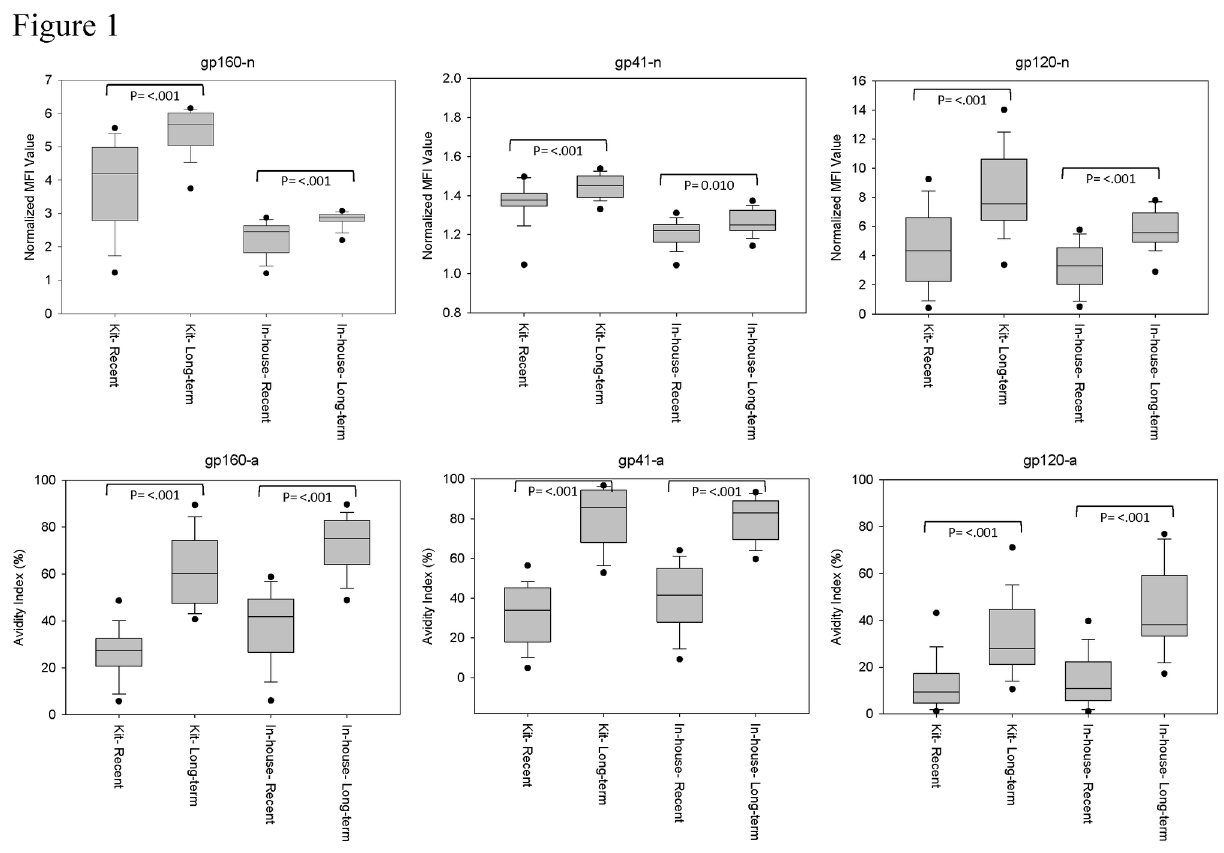
Figure 1. Performance of in-house assay versus prototype kit. The normalized MFI values (n) and avidity index (a) for the in- house assay and kit were compared for drug naïve, known recent (infected <6 months) and long-term (infected >1 year) specimens. The boxes represent the 25 th to 75 th percentile of reactivity, while the middle lines represent the median values. Black dots indicate the 5 th to 95 th percentile of